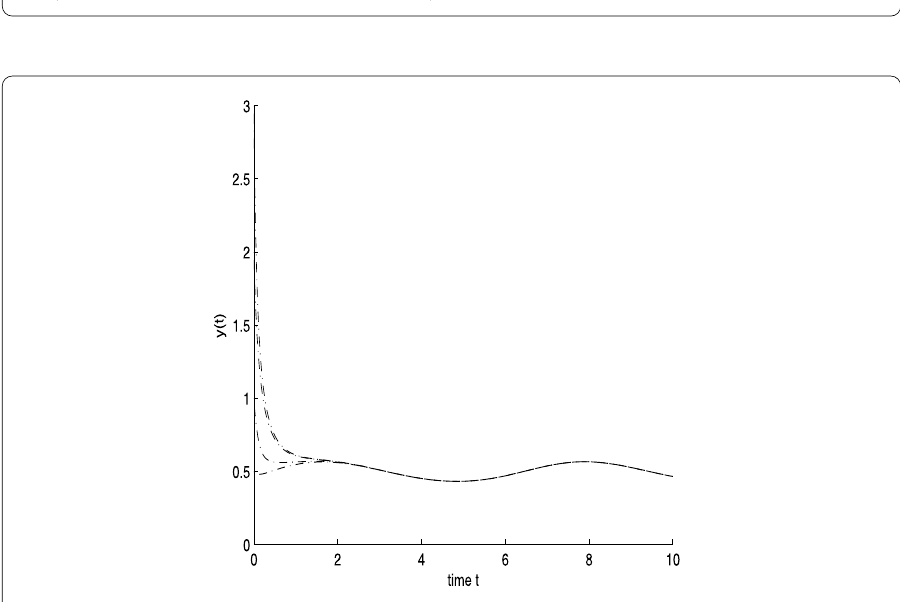
Figure 2 Dynamic behaviors of the predator population of the system (5.1), with the initial condition condition ( x (0), y (0)) = (6,2),(2,0.5),(0.5,1) and (4,3), respectively